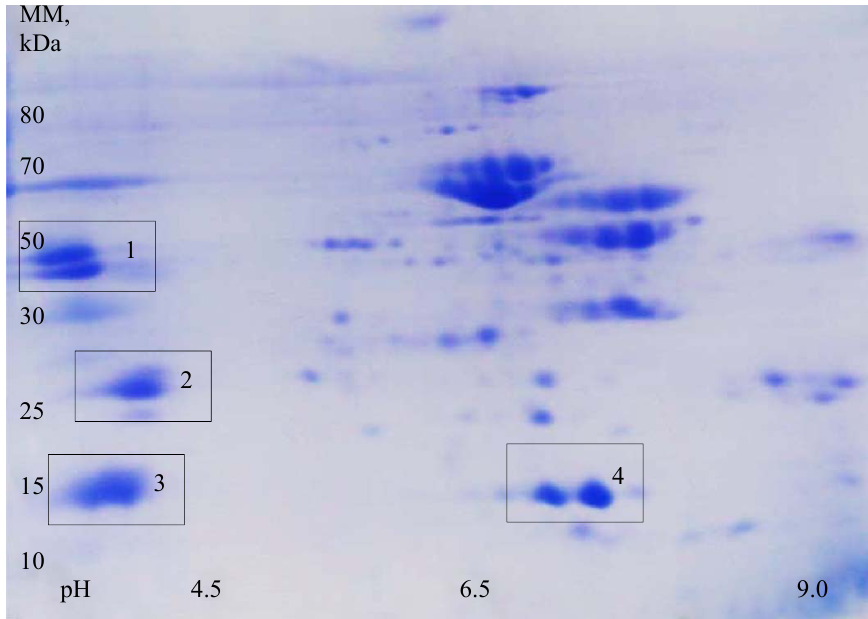
Fig. 2. 2-DE of average samples of pork longissimus and